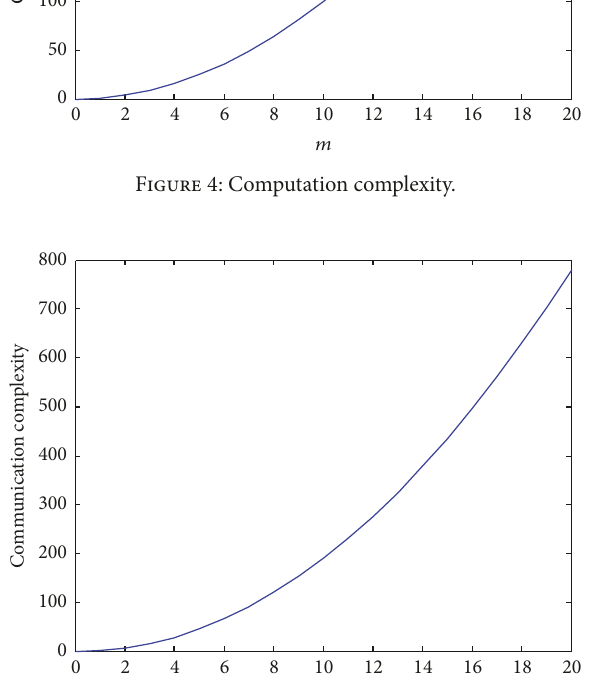
Figure 5: Communication